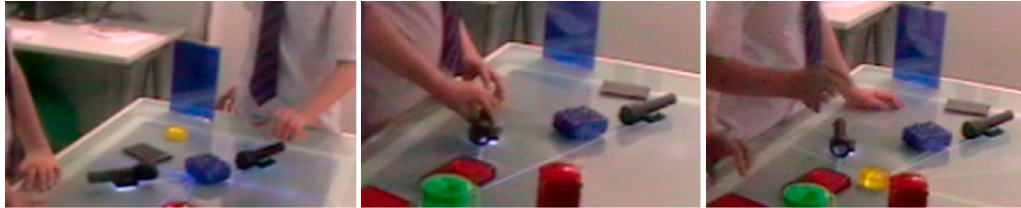
Figure 3. Boys engage in manipulating objects, but make no associations with the conceptual domain. They point both torches to the rough blue object, producing many blue beams ( left ); one boy points the torch to a smooth red object ( centre ); torches point to red and yellow objects ( right ).